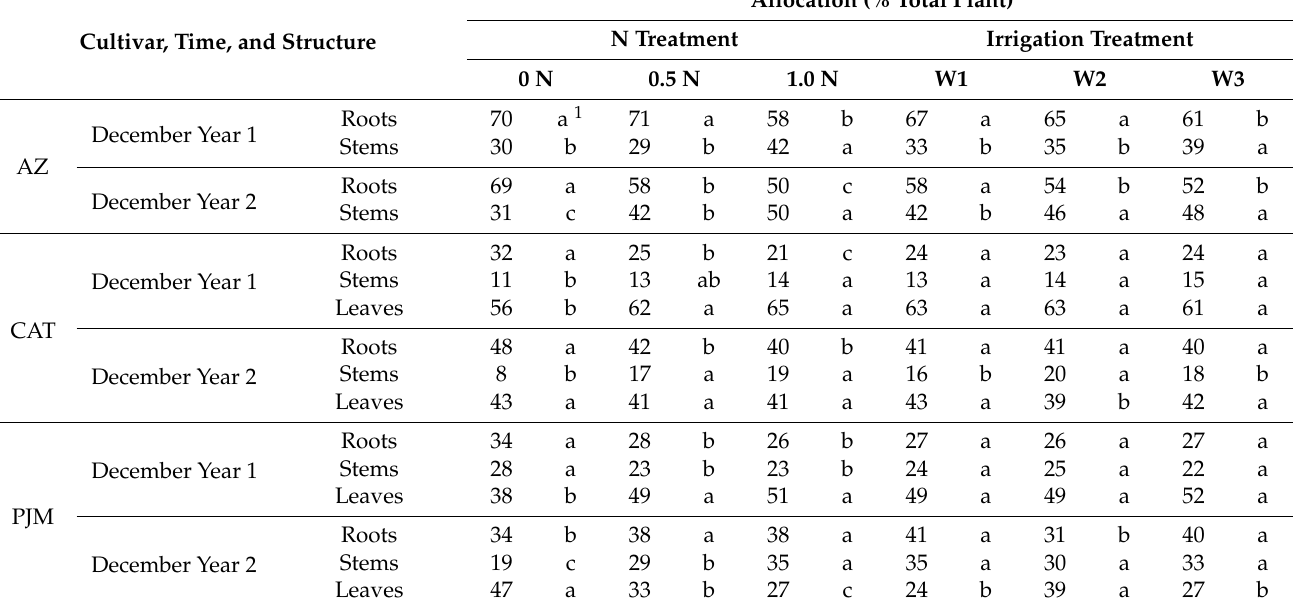
Table 1. Nitrogen (N) allocation in ‘Gibraltar’ (AZ), ‘Catawbiense Album’ (CAT), and ‘P.J.M.’ (PJM) Rhododendron . In Year 1, plants from each cultivar were grown in soilless media with N-free fertilizer (0 N) or N-free fertilizer plus 7 (0.5 N) or 14 (1.0 N) mg N per day from NH 4 NO 3 and irrigated once daily to 100% (W1) or 50% (W2) container capacity or twice daily to 100% container capacity (W3). In year 2, the plants were transplanted into